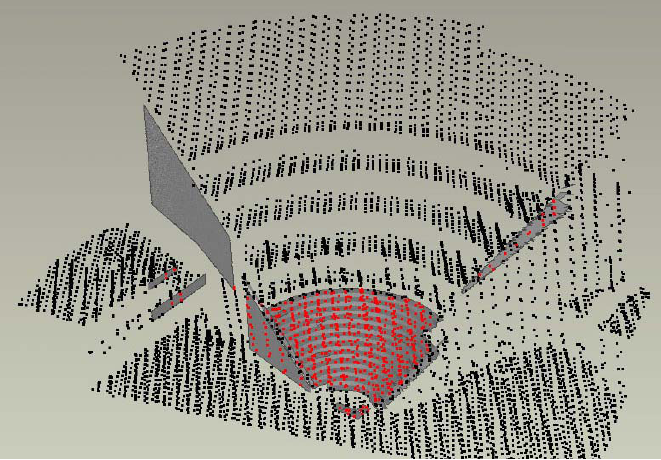
Figure 4. ICP registration results. The reference surface was a combination of photogrammetric and terrestrial laser scanning data. Only red laser points were included in registration.